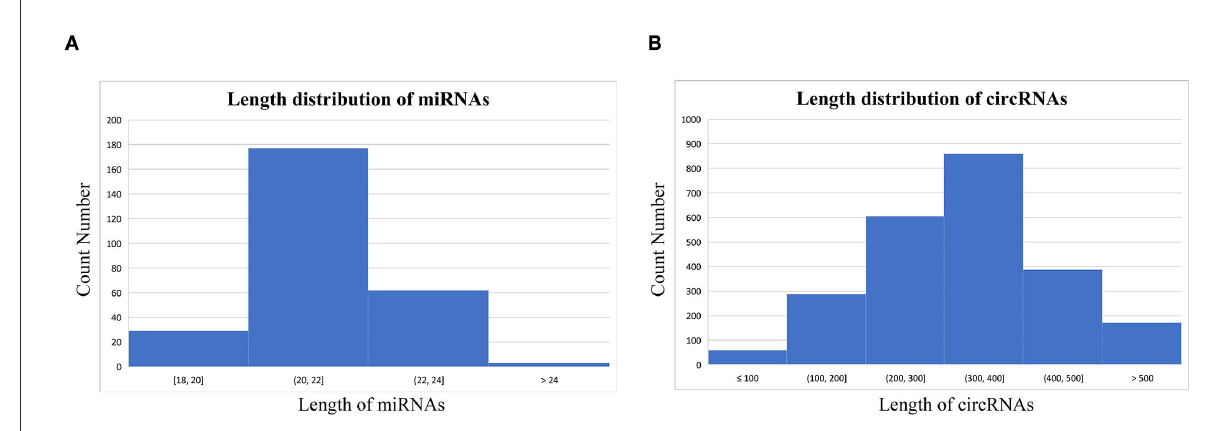
FIGURE1 Length distribution of the distinguished micro ribonucleic acids (miRNAs) (A) and circular RNAs (circRNAs) (B)